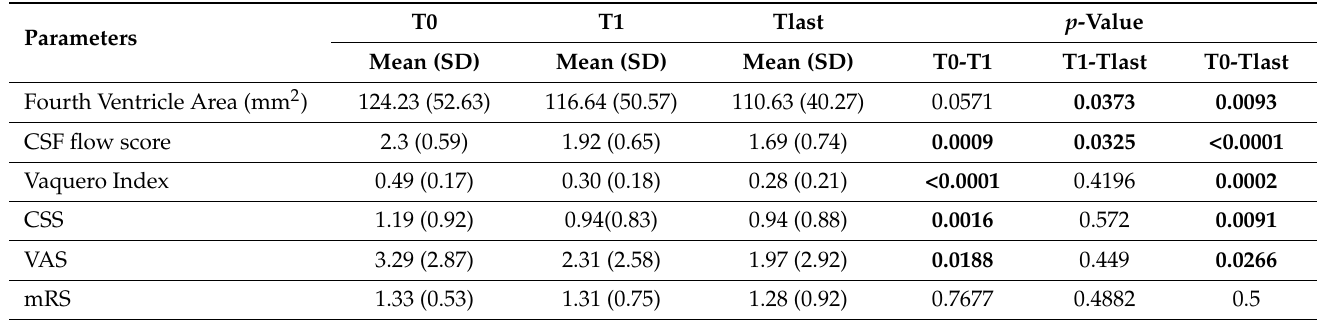
Table 5. Radiological and clinical changes at T0-T1, T0-Tlast, T1-Tlast (statistical